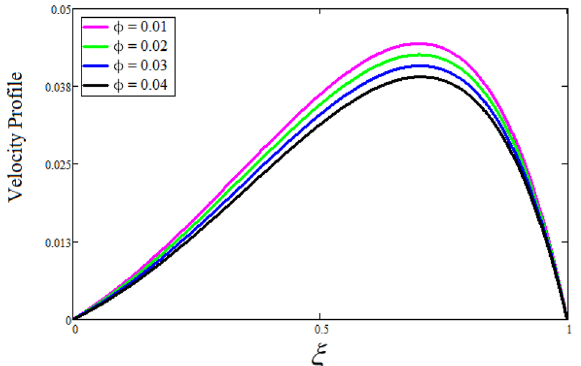
Figure 3. The consequence of φ on the velocity distribution. Where R ζ = 2, δ = γ = π 3 , M = 5, k = 0.3, Gr = 10, Gm = 20, β = 0.2, α = 0.5, t = 1, Sc = 10,